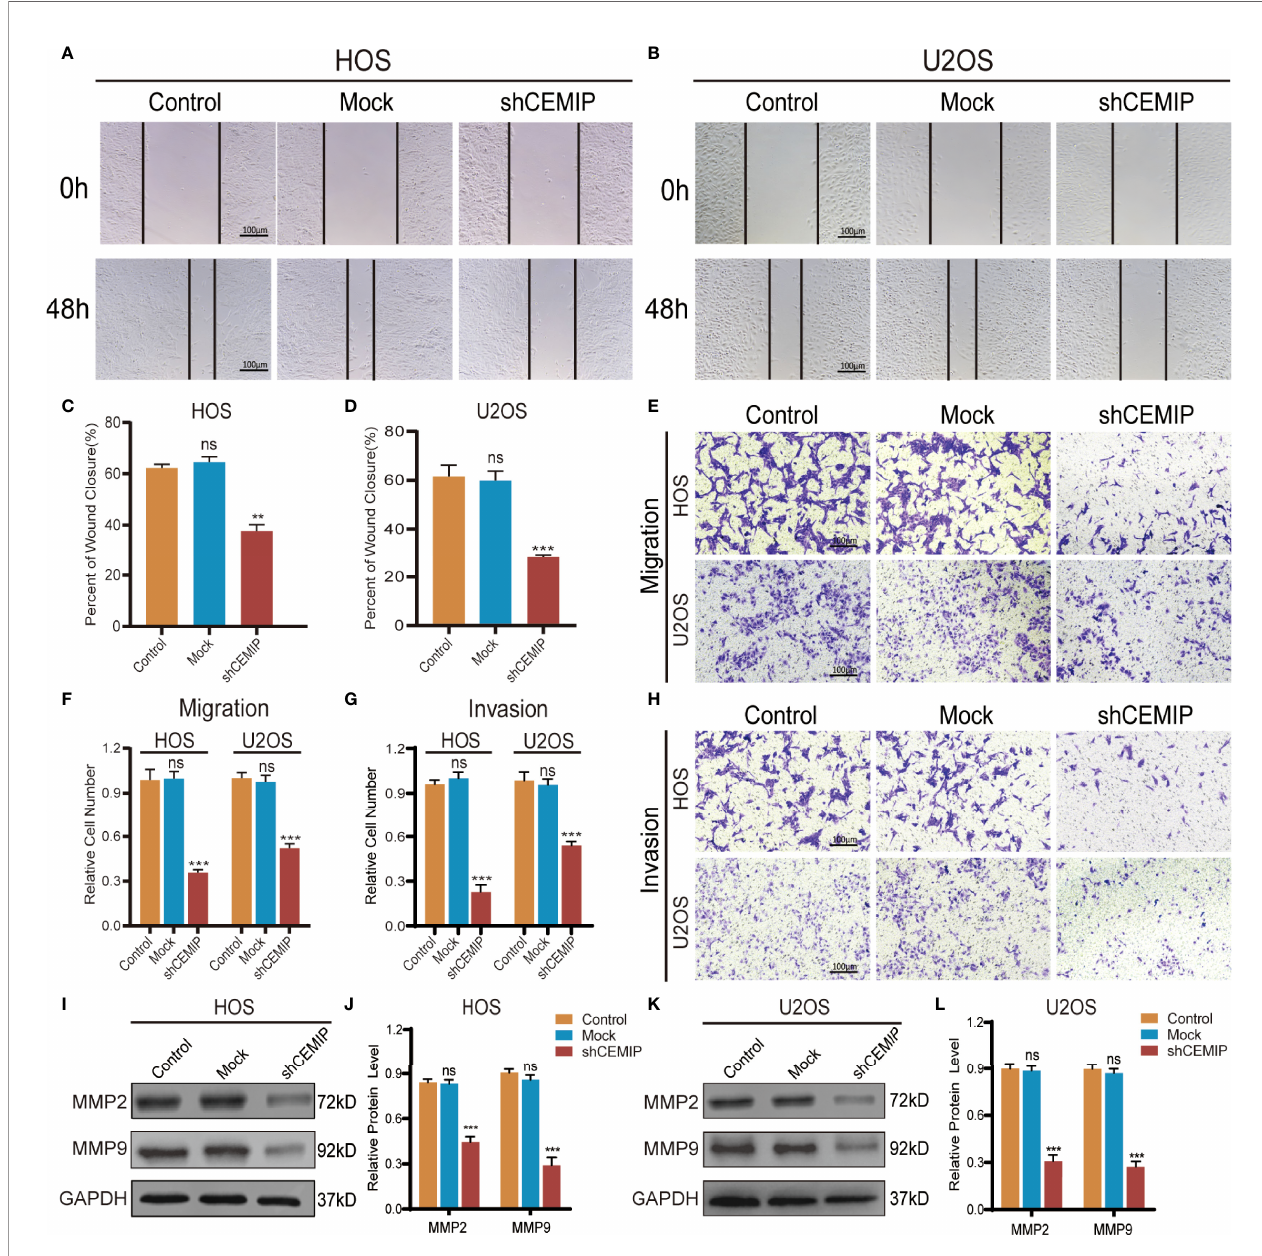
FIGURE 3 | CEMIP promotes the invasion and metastasis of osteosarcoma cells. (A, C) Cell migration capacity in HOS were detected by wound healing assays and their quantitative analysis. (B, D) Cell migration capacity in U2OS were detected by wound healing assays and their quantitative analysis. (E, F) Cell migration ability in HOS and U2OS cells were analyzed by transwell migration assays and their quantitative analysis. (G, H) Cell invasion ability in HOS and U2OS cells were analyzed by transwell invasion assays and their quantitative analysis. (I, J) Western blot and the relative protein expression of MMP2 and MMP9 in HOS cells. (K, L) Western blot and the relative protein expression of MMP2 and MMP9 in U2OS cells. ** P < 0.01, *** P < 0.001. ns, no signi fi